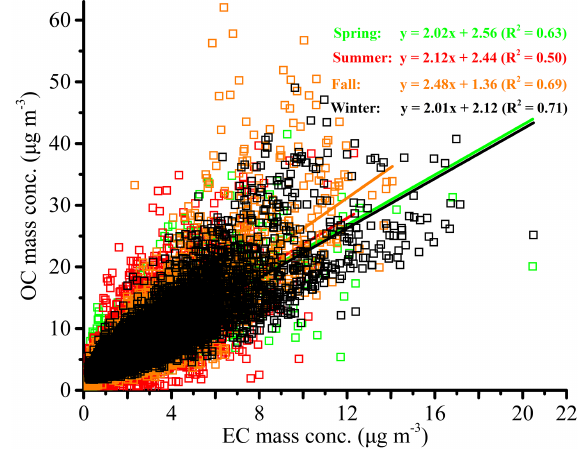
Figure 7. Correlation between EC and OC mass concentrations dur- ing different seasons in Shanghai.